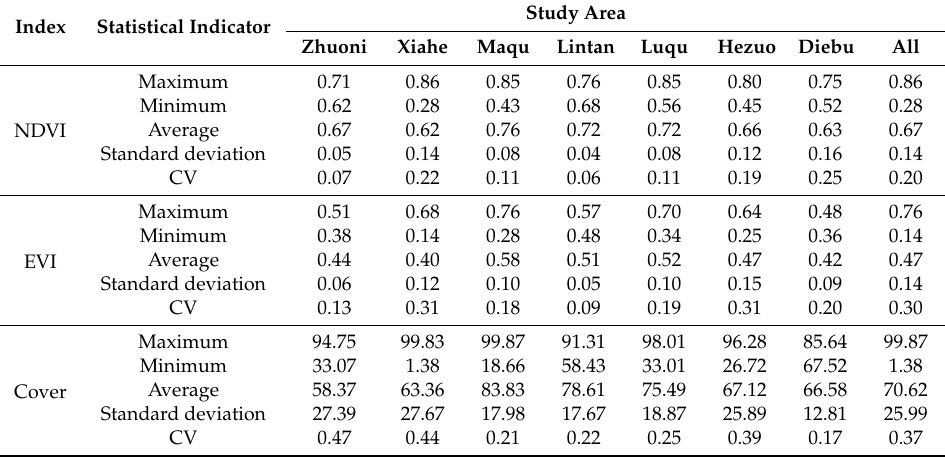
Table 2. Descriptive statistics of grassland cover and corresponding moderate-resolution